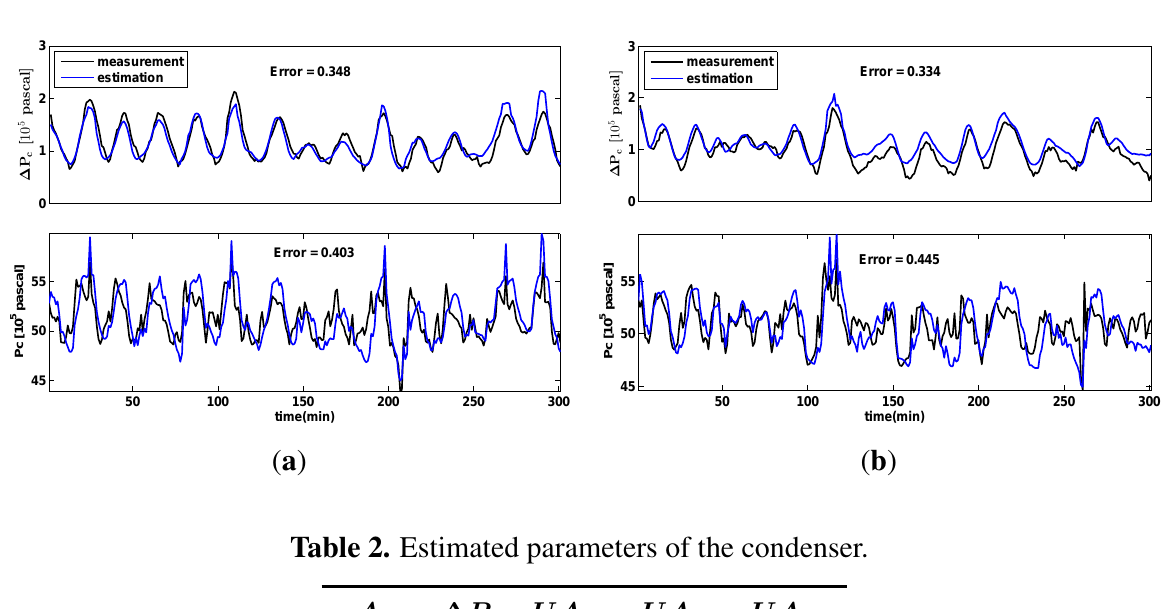
Estimation of the pressure drop and the pressure at the condenser inlet.